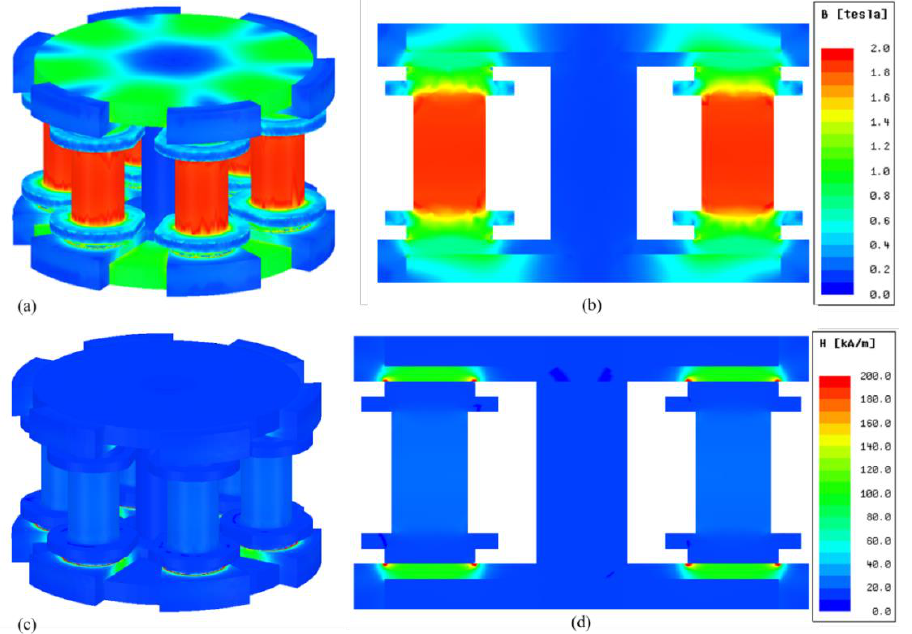
Figure 6. Magnetic density B on ( a ) full view and ( b ) cross-section view of mount, and magnetic intensity H on ( c ) full view and ( d ) cross-section view of mount.